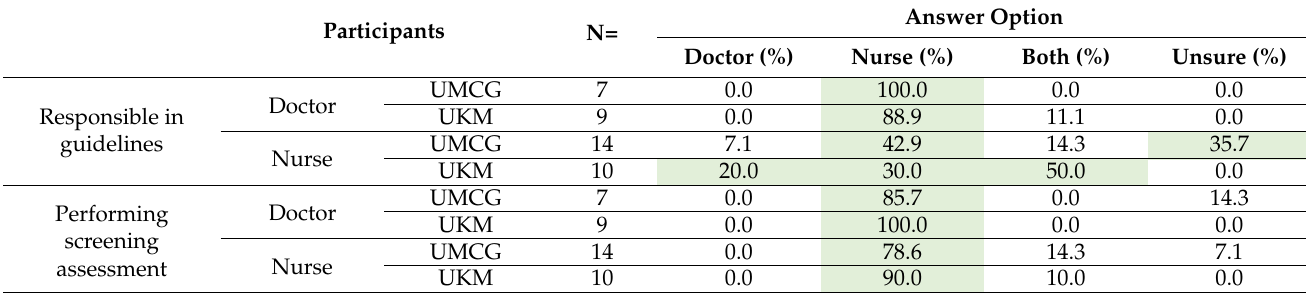
Table 5. Survey responses of healthcare professionals for MDRO screening